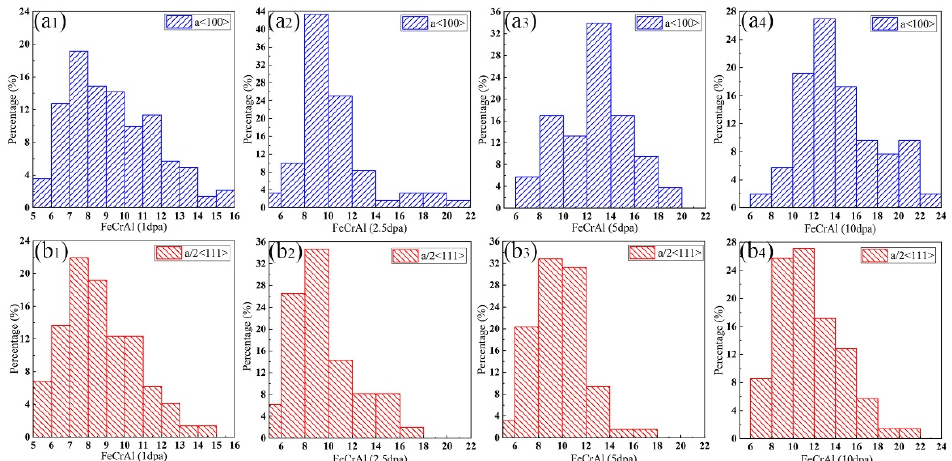
Figure 5. Size distribution of ( a 1 – a 4 ) a<100> dislocation loops, and ( b 1 – b 4 ) a/2<111> dislocation loops in FeCrAl alloy after irradiation to 1.0 dpa, 2.5 dpa, 5.0 dpa and 10.0 dpa.